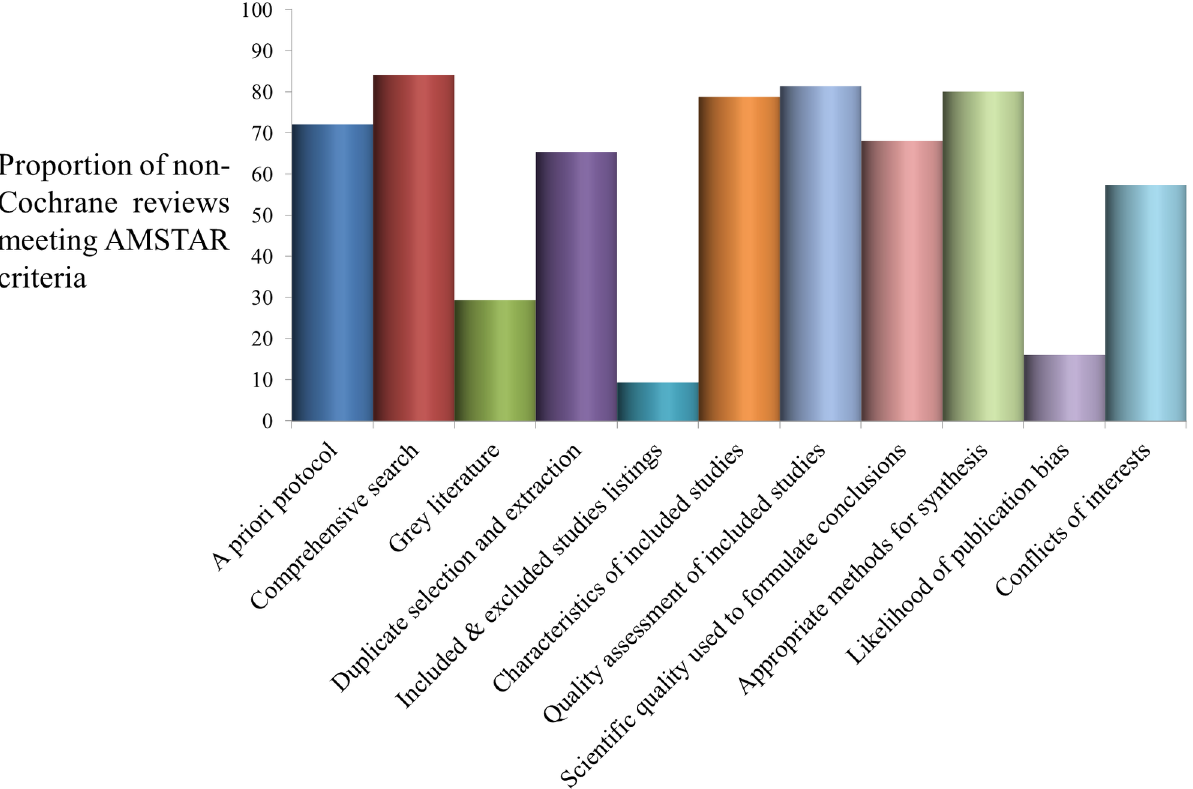
Fig 3. Quality assessment of contributing evidence from non-Cochrane systematicreview &